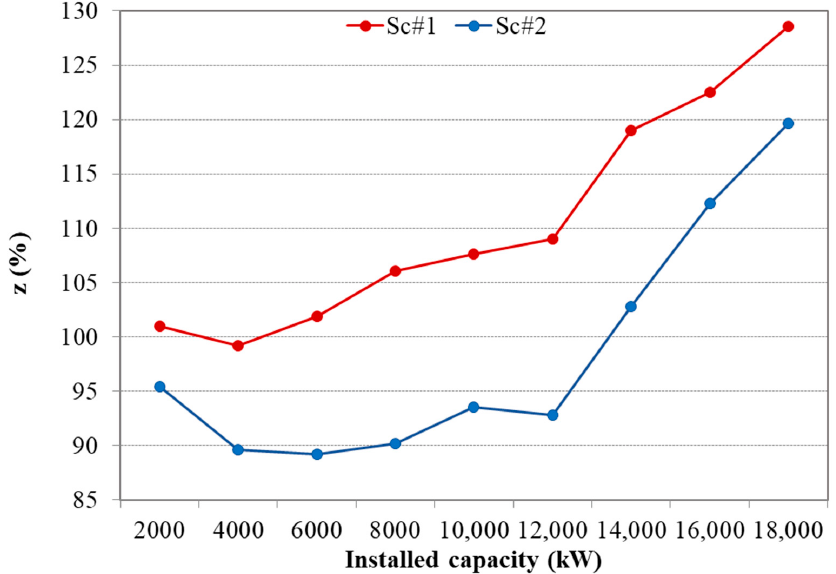
Figure 5. The z index as a function of PV installed capacity in both Sc#1 and Sc#2.